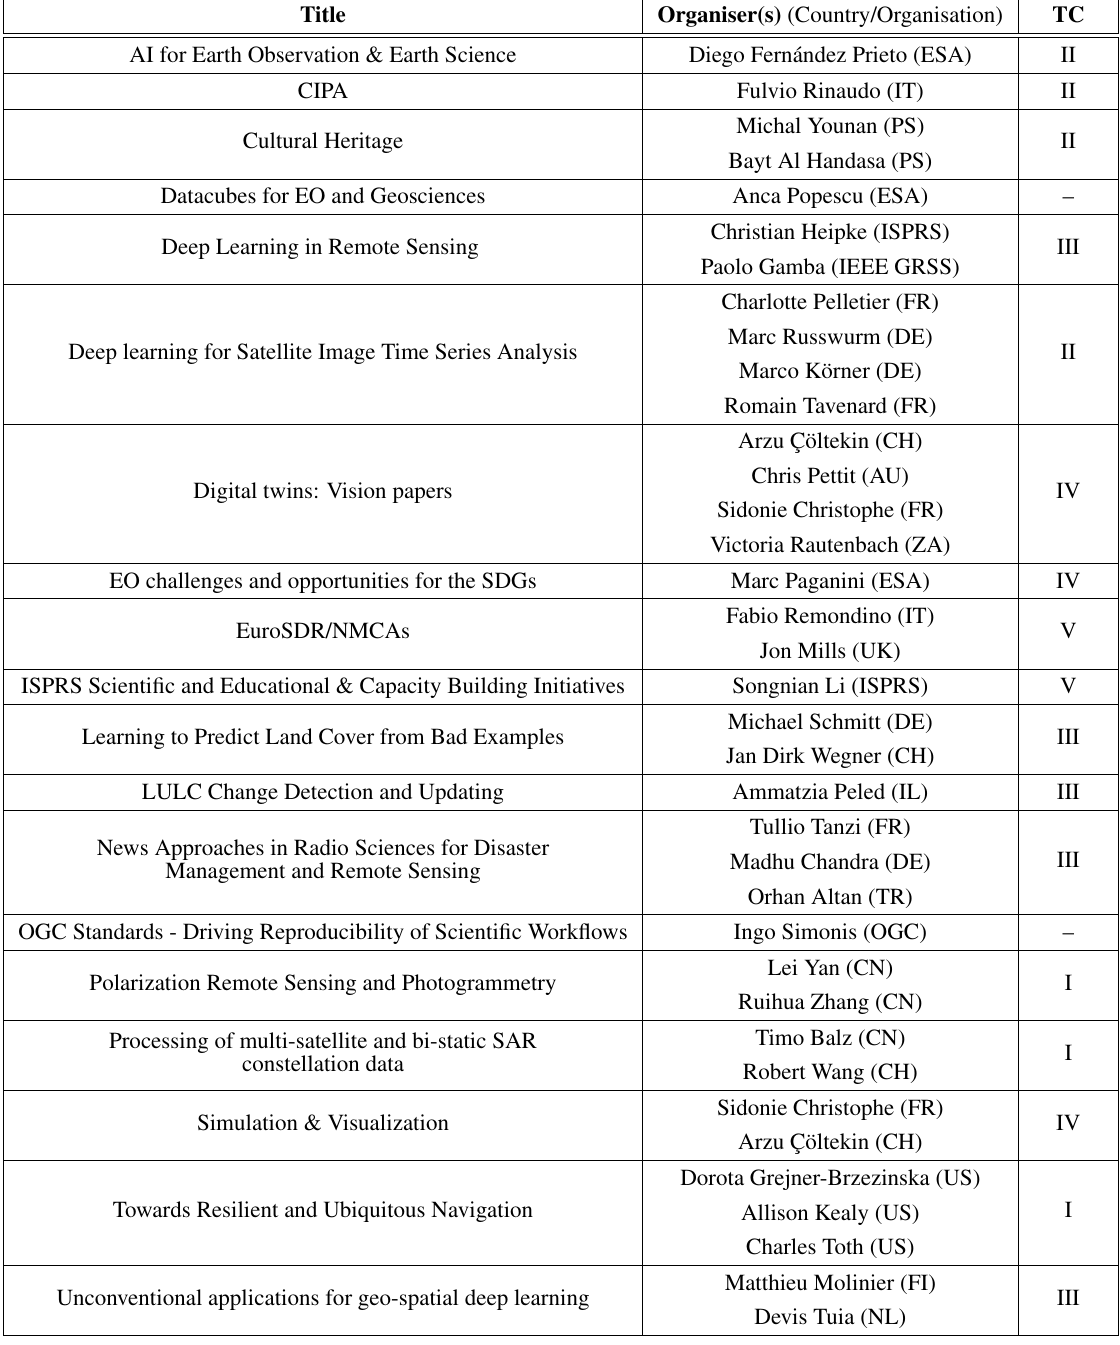
Table 1. Thematical Sessions of the 2020 edition of the ISPRS Congress. OGC session is not related to any TC since no final papers were received after Congress